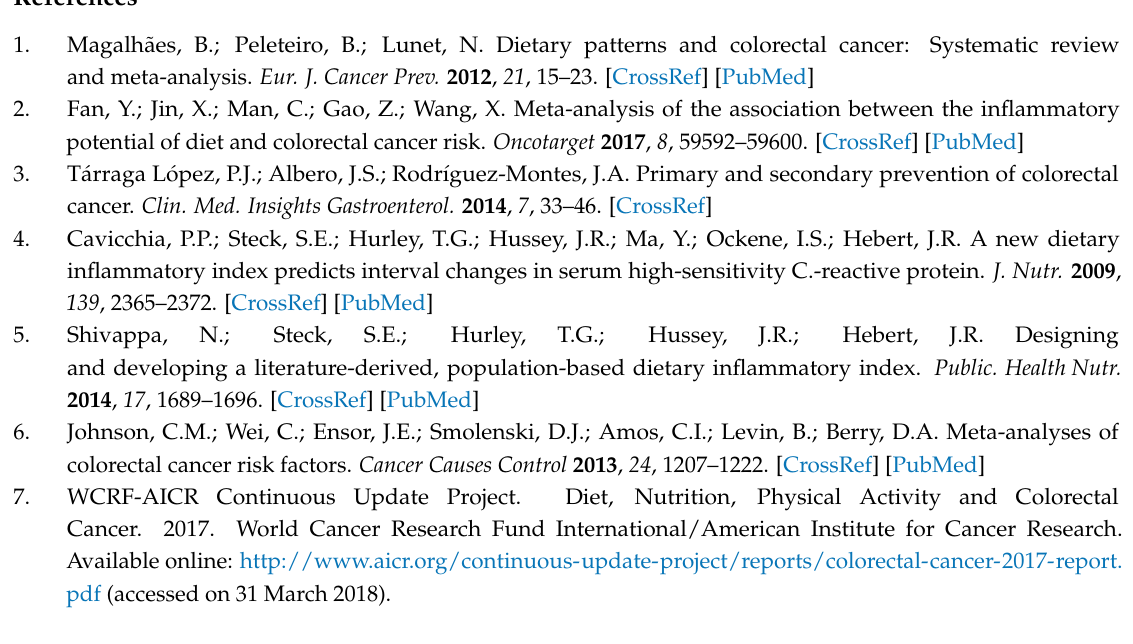
Table S1. Comparisons on demographic/environmental factors per race groups; Table S2. Comparisons on dietary parameters: Healthy Eating Index per race groups; Table S3. Comparisons on dietary parameters: Recommended daily intakes per race groups; Table S4. Major dietary parameters as predictors of colorectal cancer; Table S5. Gene-diet interactions on the predictors of colorectal cancer: Baseline logistic regression model and generalized regression Elastic Net models; Table S6. Baseline logistic regression and generalized regression Elastic Net on the selected predictors of colorectal cancer from genetic and dietary factors; Figure S1. Gene-diet Interaction: (a). prediction profiler, interaction profiles – gender interacting with overweight per body mass index (BMI), MTHFR 677 polymorphism interacting with overweight based on BMI; Figure S2. Area under the receiver operating characteristic curve (AUC) for baseline logistic regression model (left panel), Elastic Net with Akaike’s information criteria with correction (AICc) validation model (middle) and Leave-One-Out validation model (right panel) on the predictors of colorectal cancer; Supplementary File: Consent Form